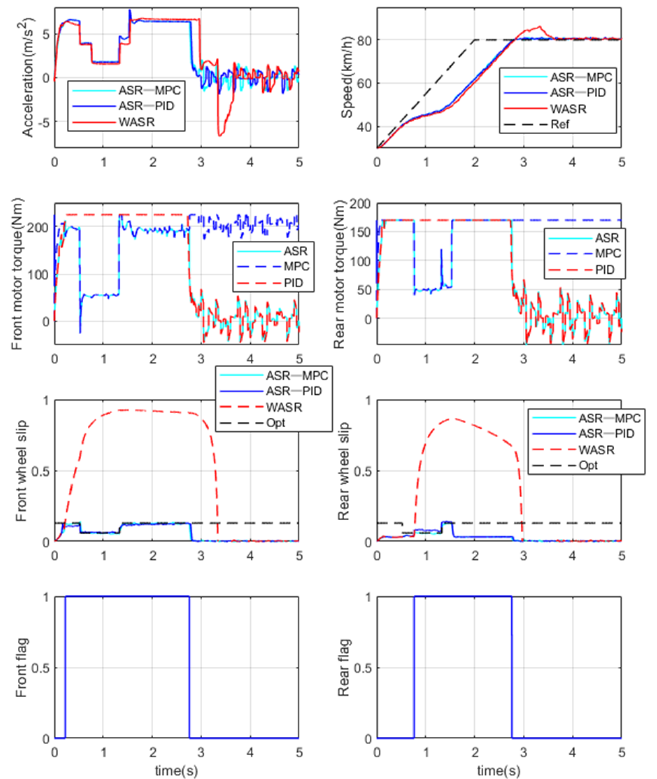
Figure 11. Vehicle accelerates on a docking road.